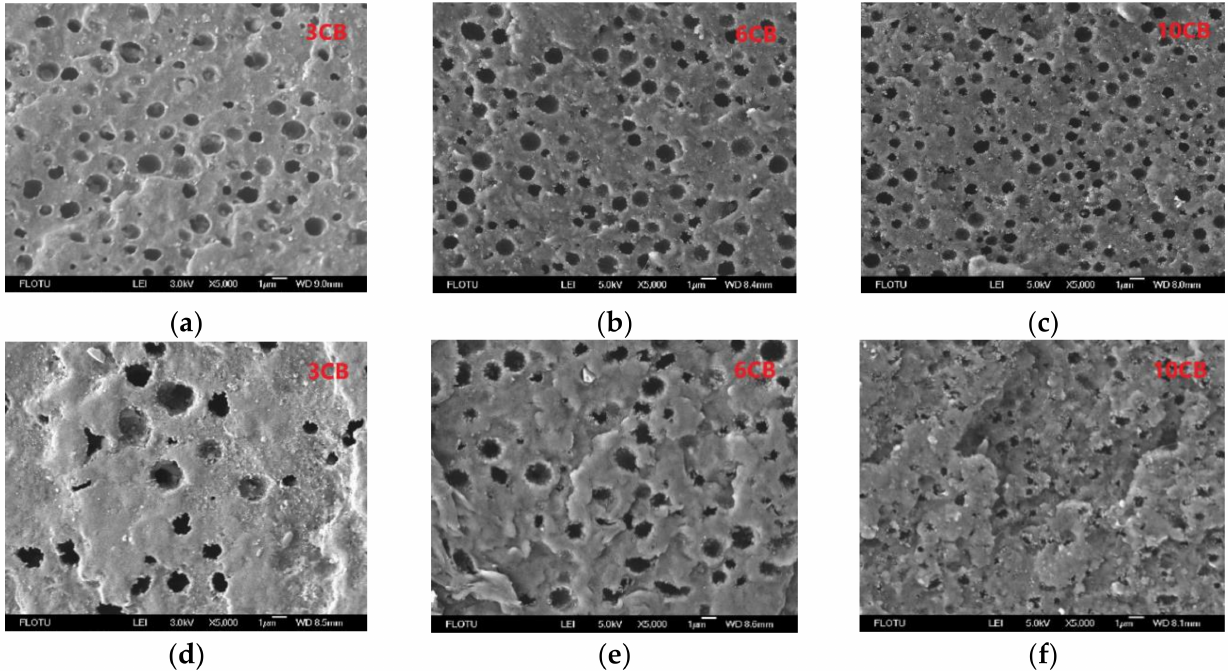
Figure 4. FESEM photos of PA6/PBT(80/20)-CB composites with different CB contents: ( a ) 3 vol%, ( b ) 6 vol%, ( c ) 10 vol%; and PA6/PBT(20/80)-CB composites with different CB contents: ( d ) 3 vol%, ( e ) 6 vol% and ( f ) 10 vol%. The PBT phase in PA6/PBT(80/20)-CB composites was etched by alcoholic solution of KOH, and the PA6 phase in PA6/PBT(20/80)-CB composites was etched by formic